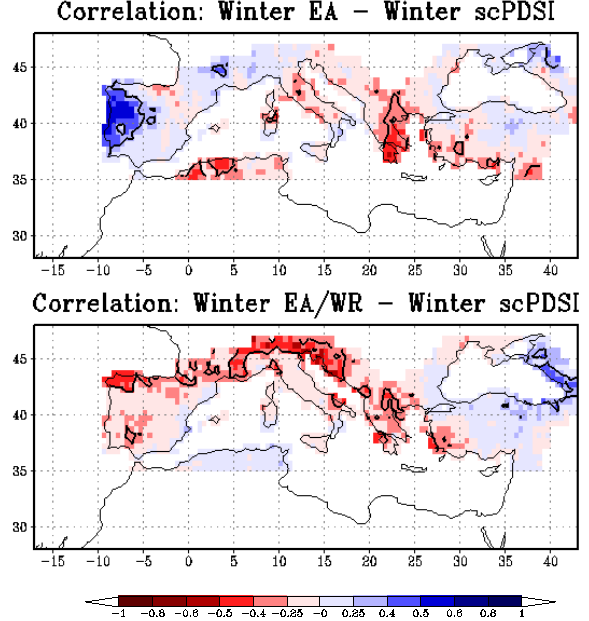
Fig. 12. Correlation between the winter EA and the winter scPDSI (top) and the winter EA/WR and the winter scPDSI (bottom) during the 1951–2000 period – circled areas are statistically significant at